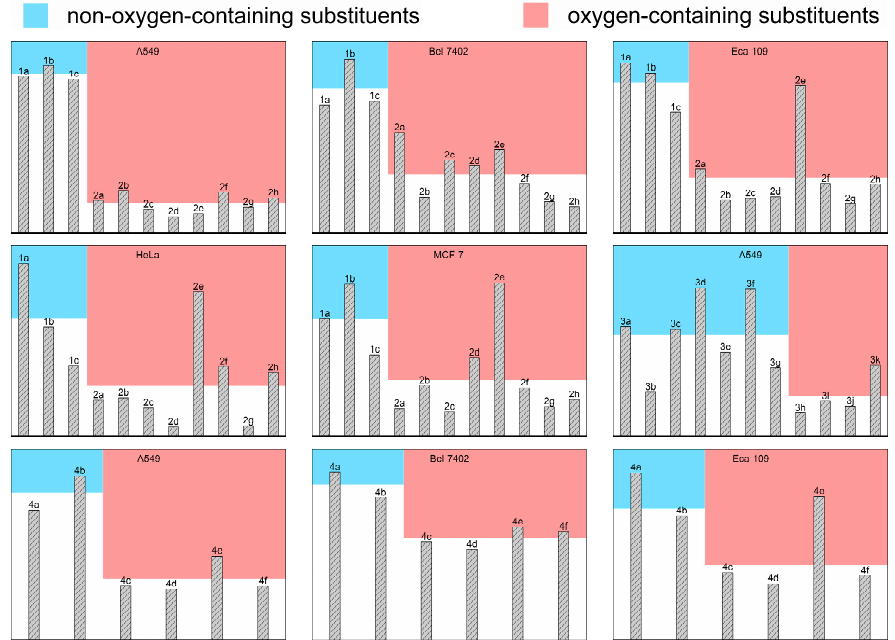
Figure 7. The in vitro anticancer activity of substituted 2,2 ′ :6 ′ ,2 ″ -terpyridine(tpy) complexes 1a – 1c , 2a – 2h , 3a – 3k [65] and 4a – 4f [44] against different cancer cell lines, including A549, Bel-7402, Eca-109, HeLa and MCF-7. The heights of the blue and red blocks on the background represent the average performance of the anticancer activity of the non-oxygen-containing substituents and oxygen-containing substituent-modified complexes, respectively. Here, 3a = [Cu(tpy)Cl 2 ], 3b = [Cu(4 ′ -(4 ′ -cyano-phenyl)-tpy)Cl 2 ], 3c = [Cu(4 ′ -(4 ′ -iodo-phenyl)-tpy)Cl 2 ], 3d = [Cu(4 ′ -(4 ′ -bromo-phenyl)-tpy)Cl 2 ], 3e = [Cu(4 ′ -(4 ′ -chloro-phenyl)-tpy)Cl 2 ], 3f = [Cu(4 ′ -(4 ′ -fluoro-phenyl)-tpy)Cl 2 ], 3g = [Cu(4 (cid:48) -( p -hydroxyl-phenyl)-tpy)Cl 2 ], 3h = [Cu(4 (cid:48) -( m -hydroxyl-phenyl)-tpy)Cl 2 ], 3i = [Cu(4 (cid:48) -( o - hydroxyl-phenyl)-tpy)Cl 2 ], 3j = [Cu(4 (cid:48) -(methoxyl-phenyl)-tpy)Cl 2 ], 3k = [Cu(4 (cid:48) -(4 (cid:48)